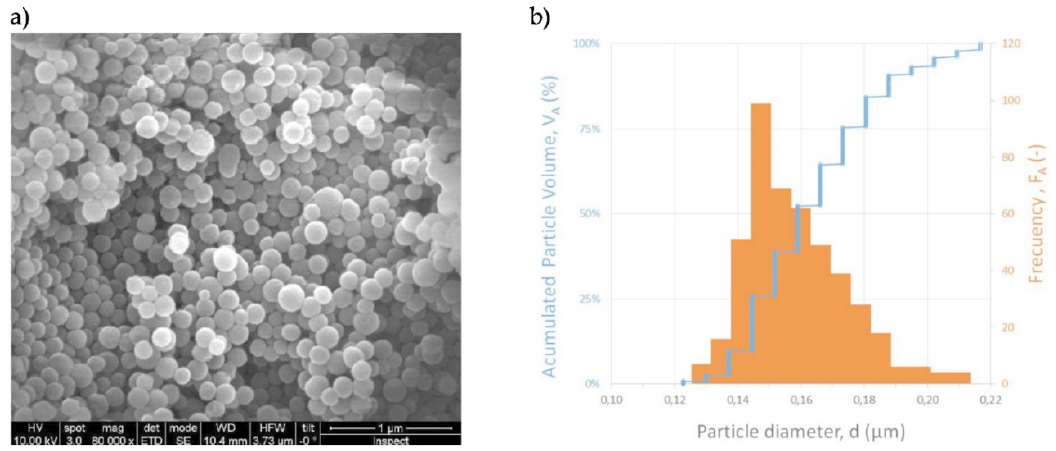
Figure 4. (a ) SEM images and ( b ) digital image processing analysis for size distribution of synthetic MCM-48 spherical particles used for the functionalization of the cantilevers.